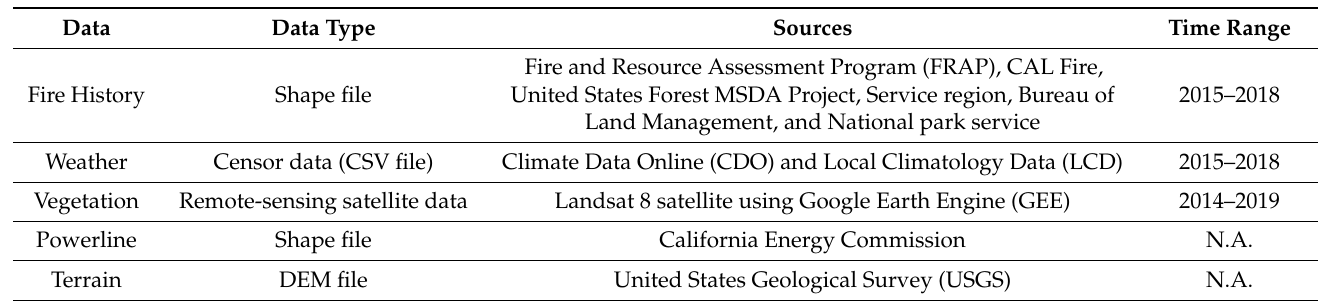
Table 2. Data types and their